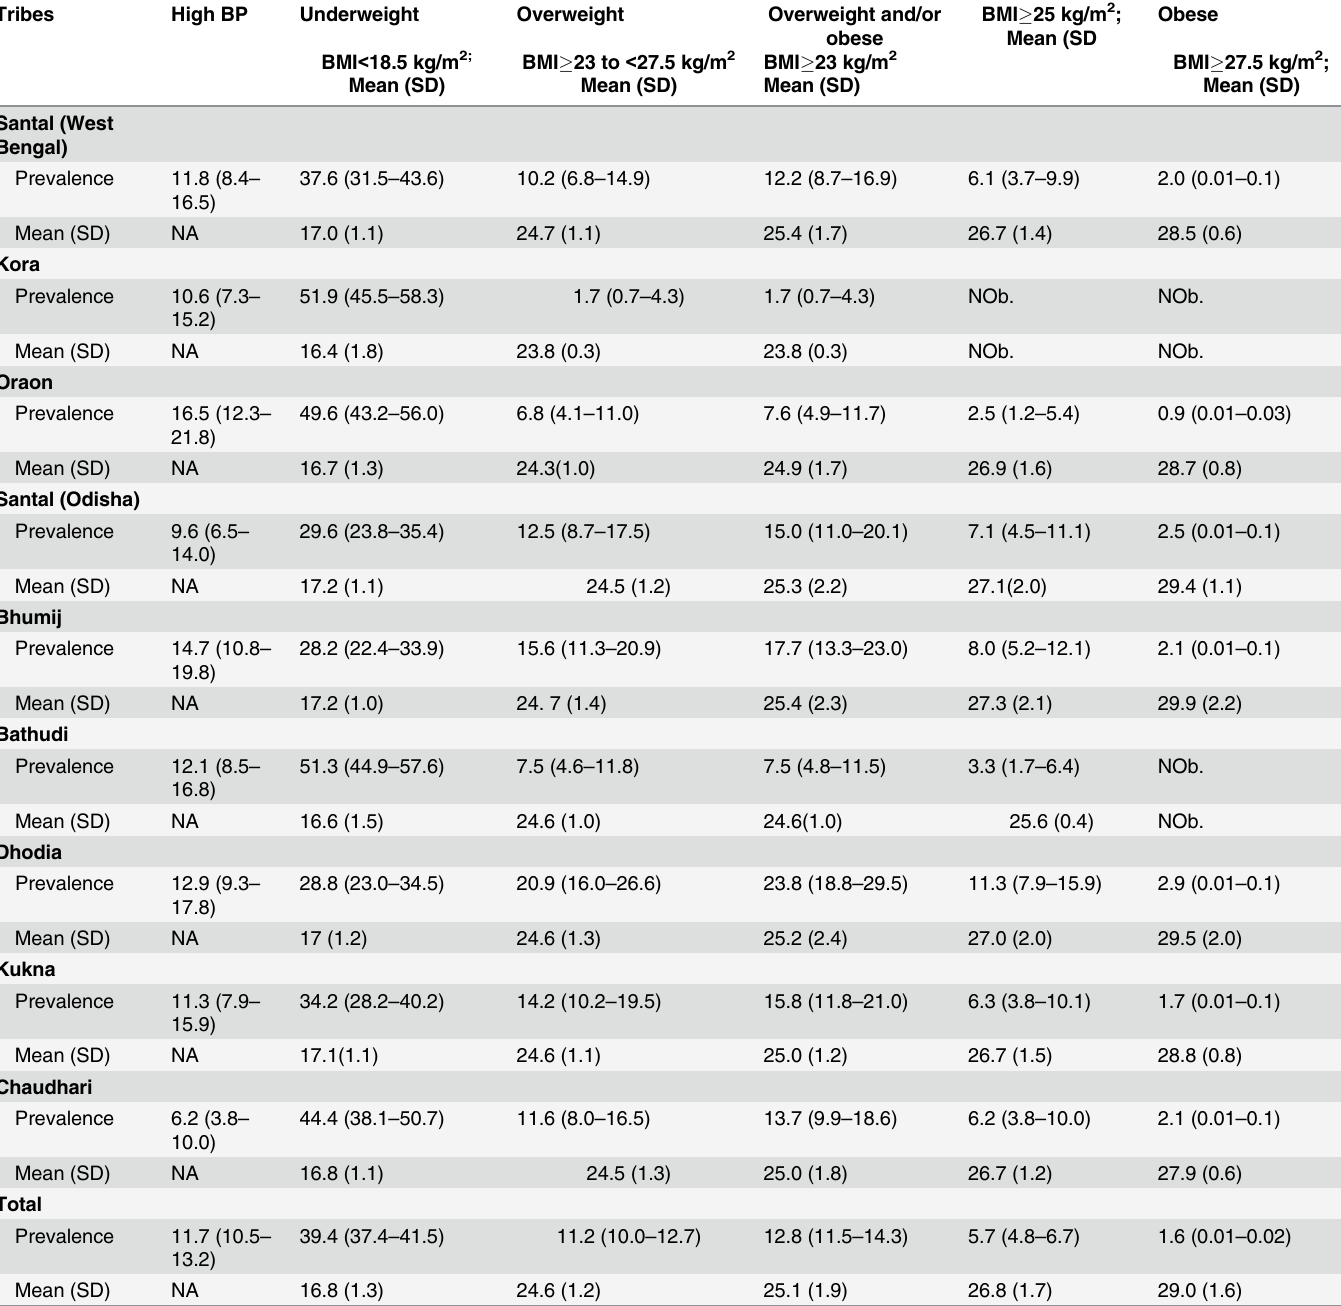
Table 2. Prevalence (%) of high blood pressure, underweight (BMI < 18.5 kg/m 2 ), overweight and/or obese (BMI (cid:1) 23 kg/m 2 ) and obese (BMI (cid:1) 27.5 kg/ m 2 ) among the selected tribes (95% CI) with mean and standard deviation. Tribes High BP Underweight Overweight Overweight and/or